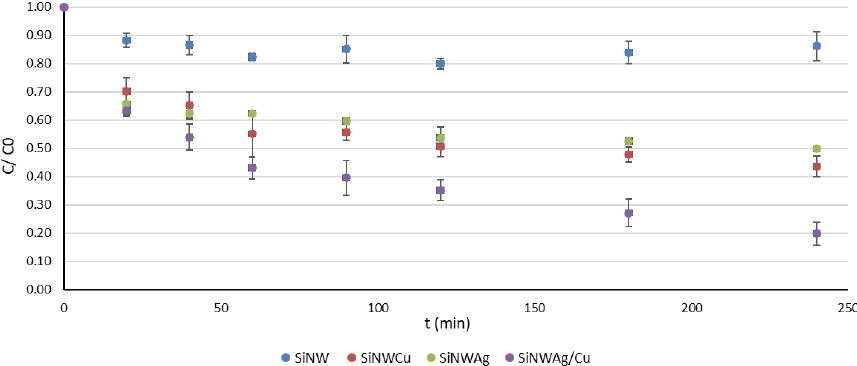
Figure 6. Duplicates of solution of C 0 = 15 mg/L Cr(VI), 5 mM citric acid and 1.2 g catalyst/L, under solar irradiation, at pH 2.8.